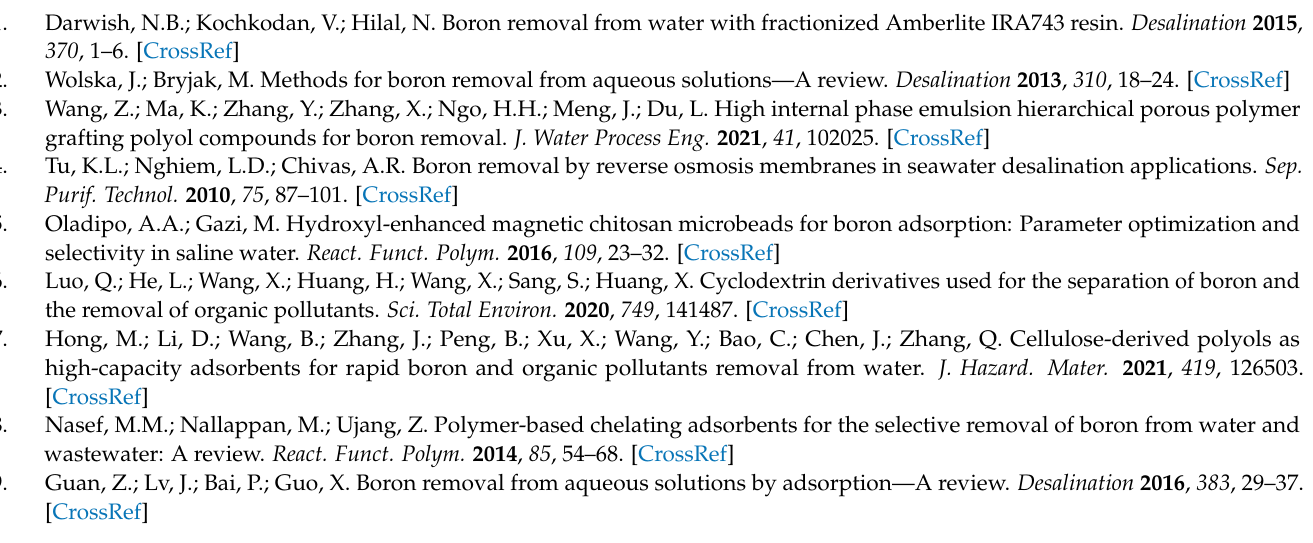
Figure S1: Standard curve of boron concentration; Figure S2: Fraction of boron in the aqueous solution at different pH